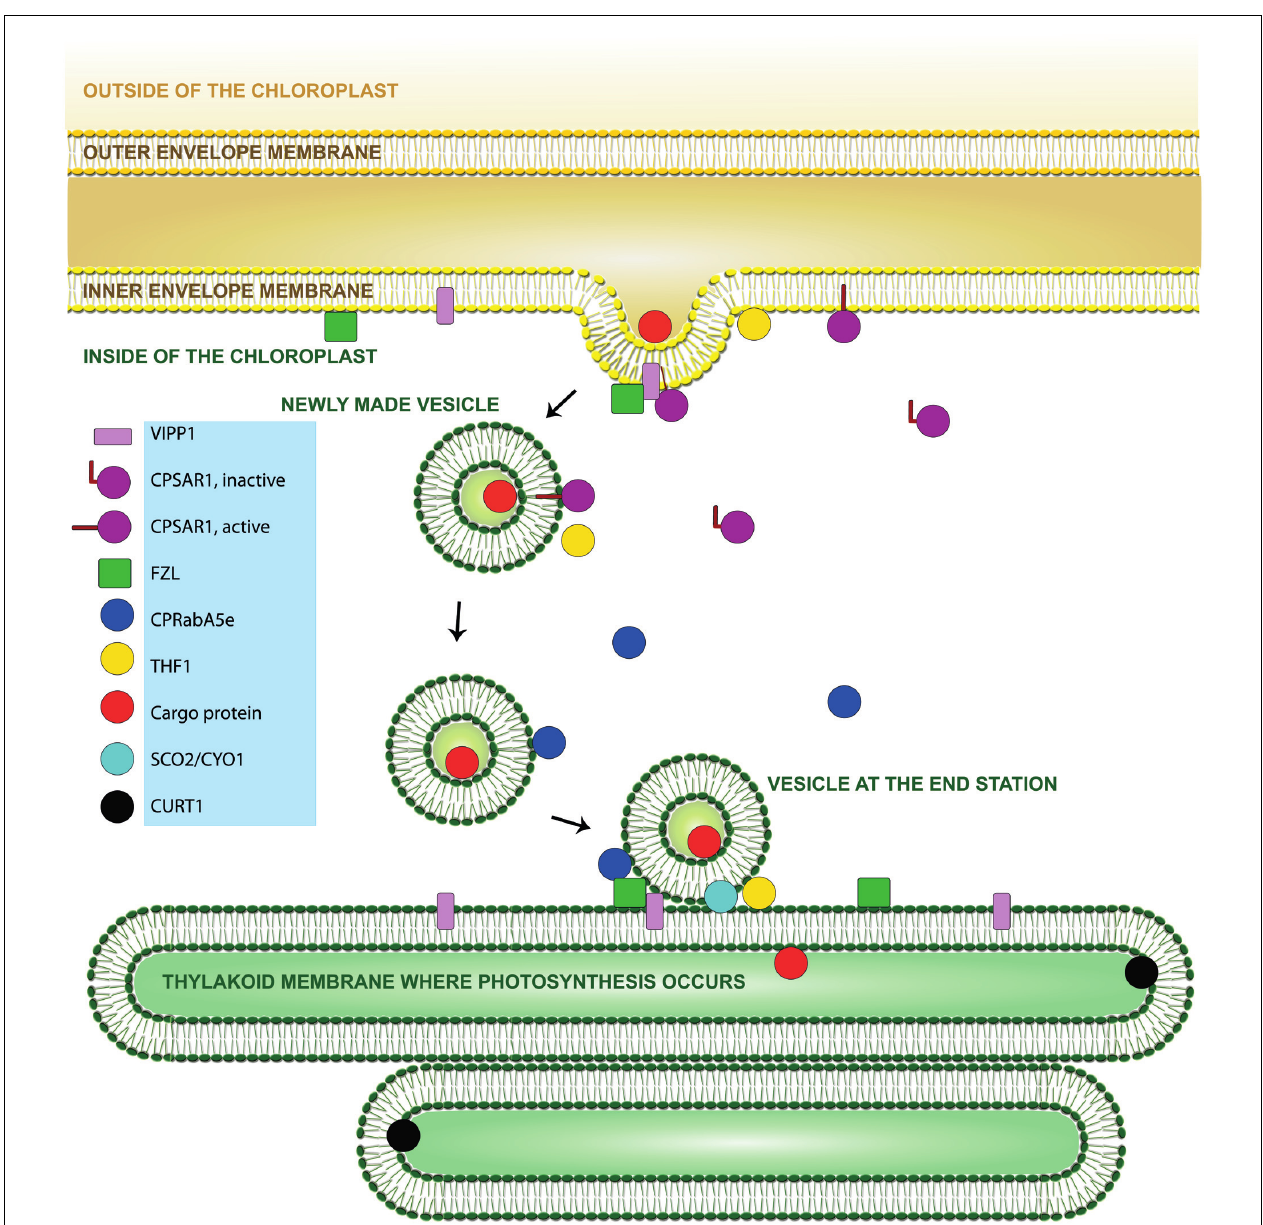
FIGURE 2 | Schematic diagram of vesicle formation and movement in chloroplasts. Proteins included are those with suggested involvement in chloroplast vesicle transport, and verified to be chloroplast localized. VIPP1 (pink), FZL (green), and THF1 (yellow) are located both at the donor membrane (inner envelope) and the acceptor membrane (thylakoids), and could thus participate in both fission and fusion of vesicles. CPSAR1 (violet) is located at the donor membrane, the vesicle and in the stroma, indicating that it plays a similar role as the cytosolic Sar1, i.e., in an active GTP-bound